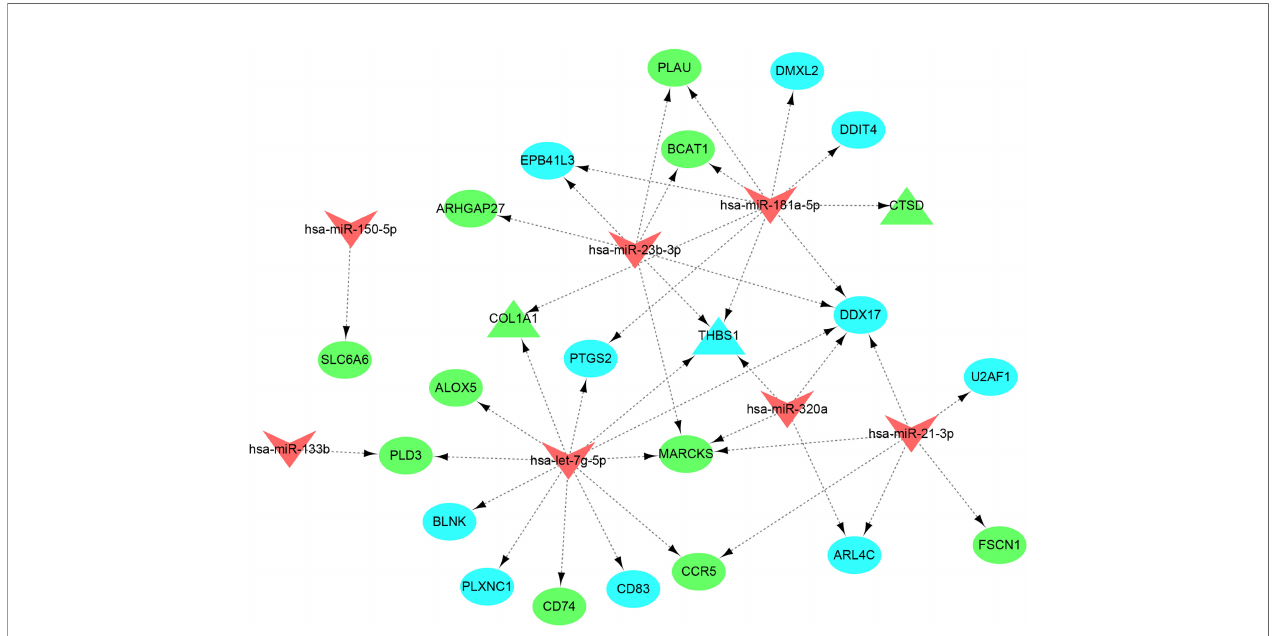
FIGURE 10 | miRNAs – shared genes regulatory network. The V-shape represents miRNA, ellipse shape represents gene, and triangle shape represents hub gene. Blue represents gene from WGCNA and green represent gene from